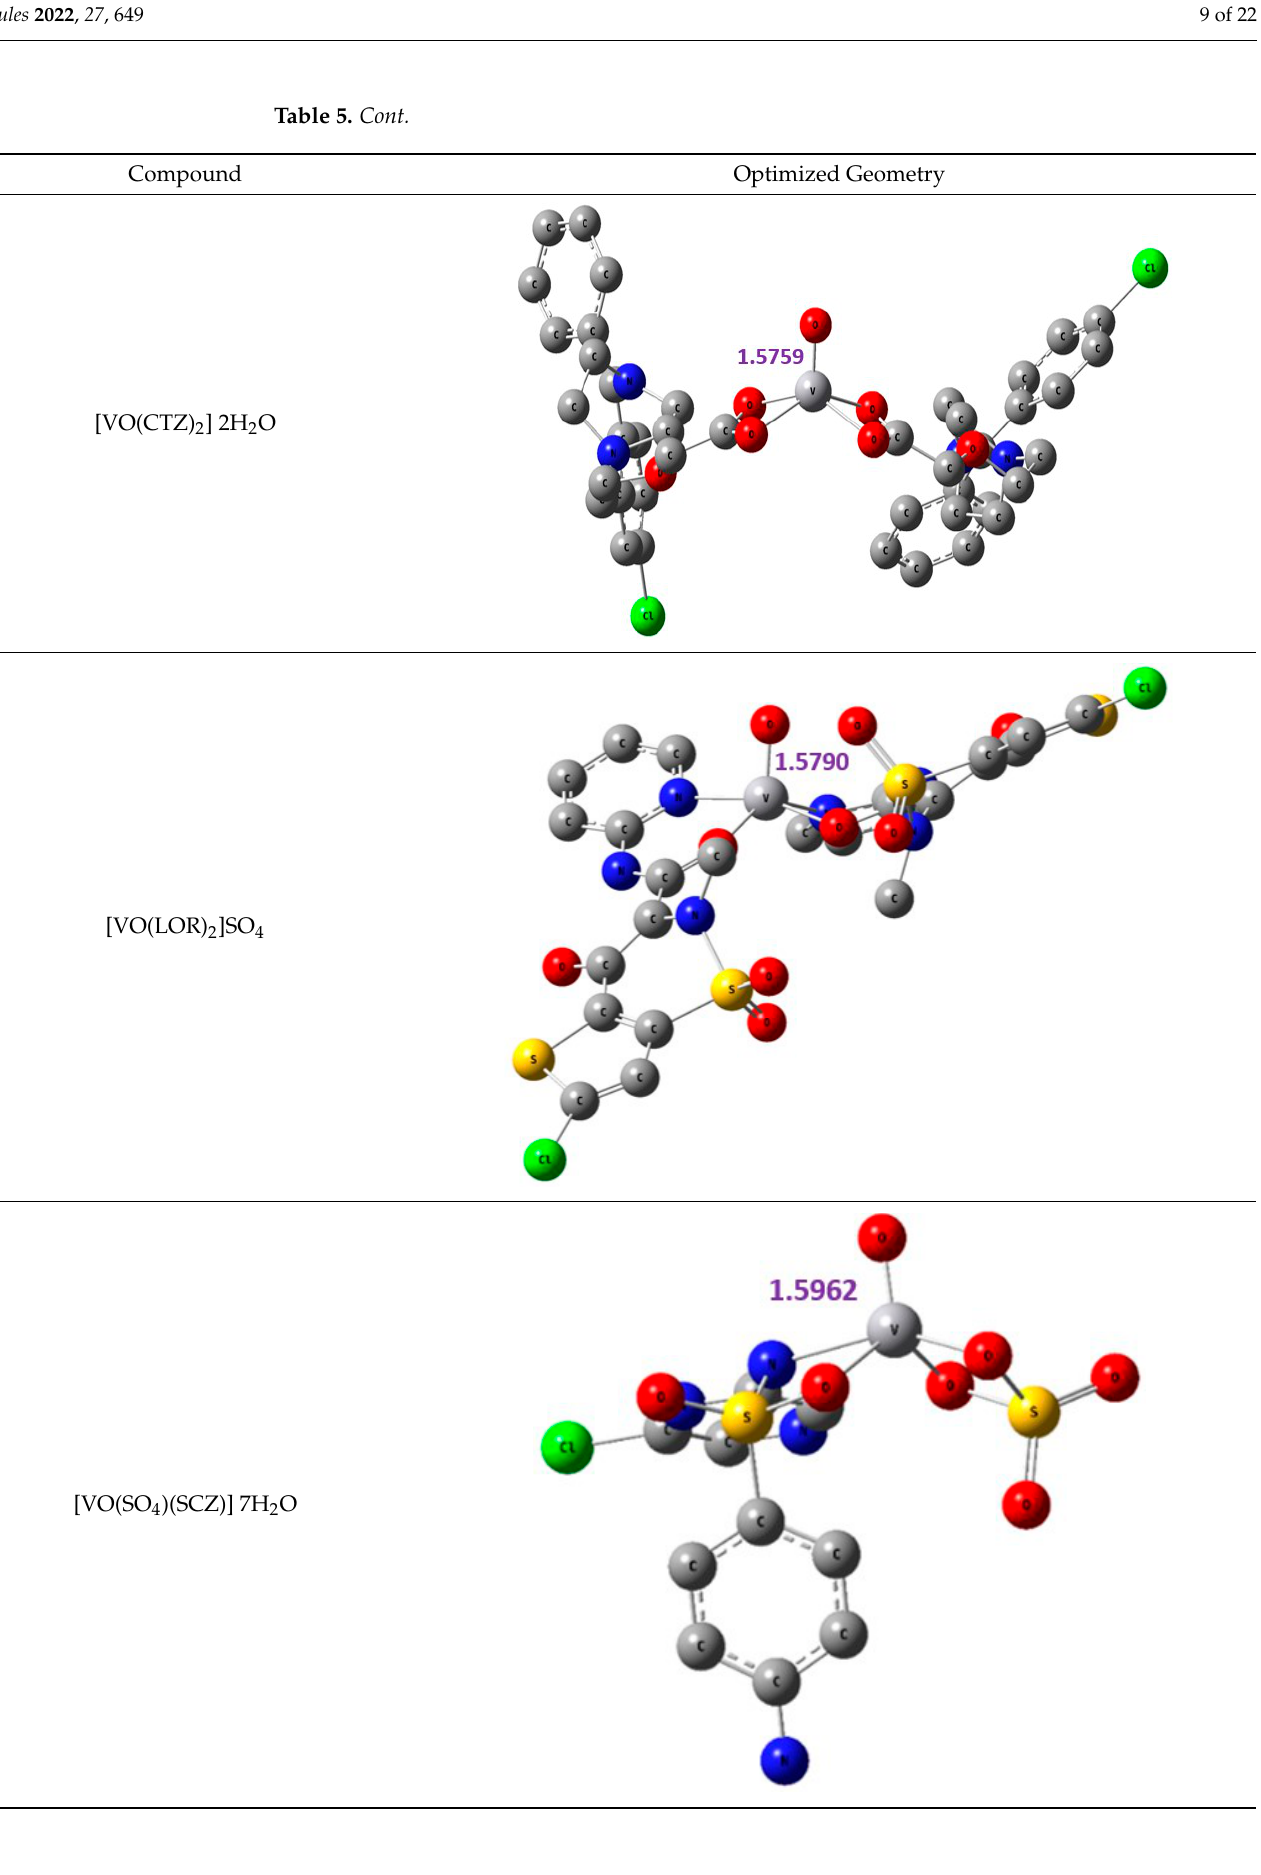
Table 6. Bond lengths and stretching frequencies for V=O Bonds in synthesized oxidovanadium(IV) complexes, experimental, and theoretical values.